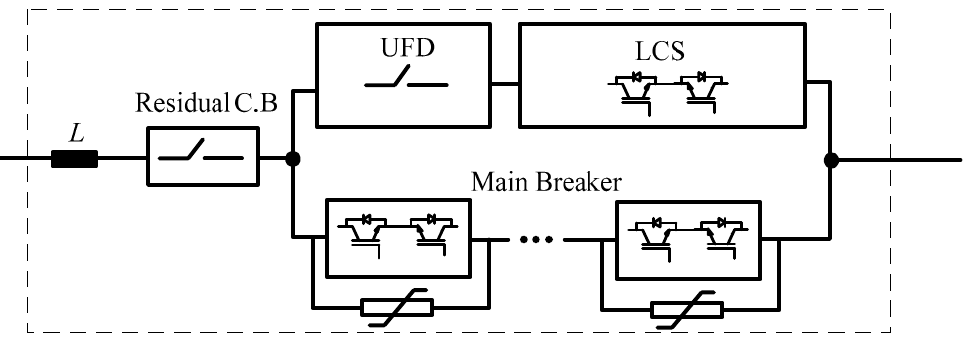
Figure 2. Structure of the ABB HVDC hybrid breaker. Table 1. Hybrid breaker components and direct current (DC) system parameters.